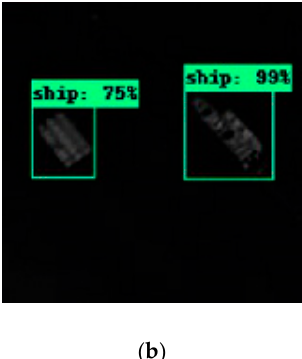
Figure 7. Images of partial experimental results. The second column represent the results of ship detection using networks trained by positive and negative sample images with the proportion of 1:1.